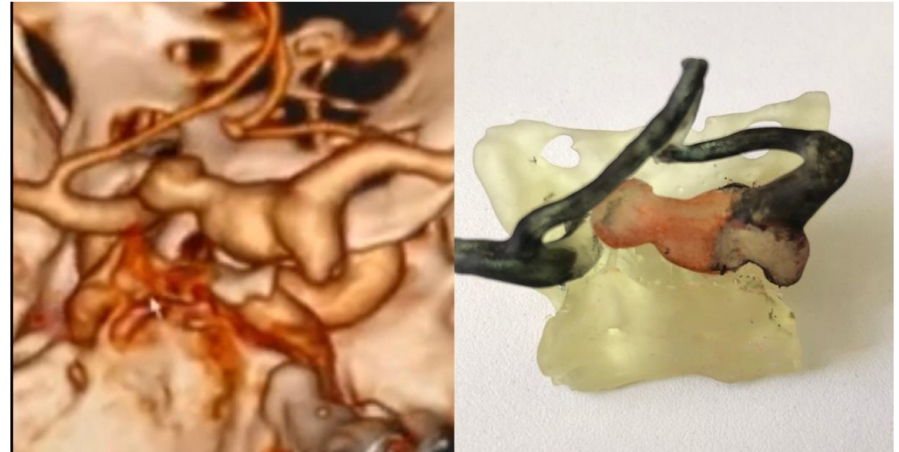
Figure 5. VRT reconstruction from CTA and 3D printed model with a complex aneurysm of Posterior Communicating